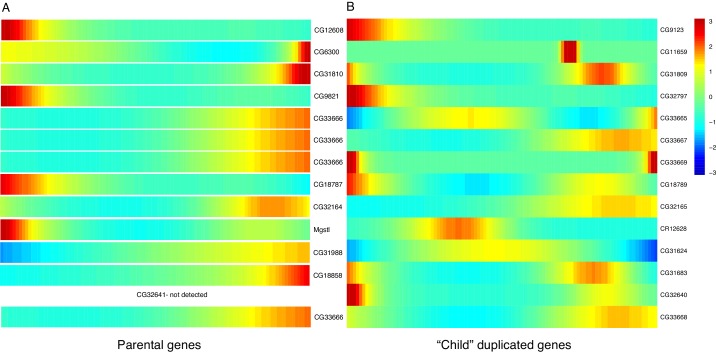
Expression heatmaps of parental and derived duplicated genes.A row is a gene, shown as it progresses along pseudotime from left to right. (A) The scaled expression of a set of parental copies of duplicated genes, plotted in pseudotime. (B) The scaled expression of the derived copies of duplicated genes.